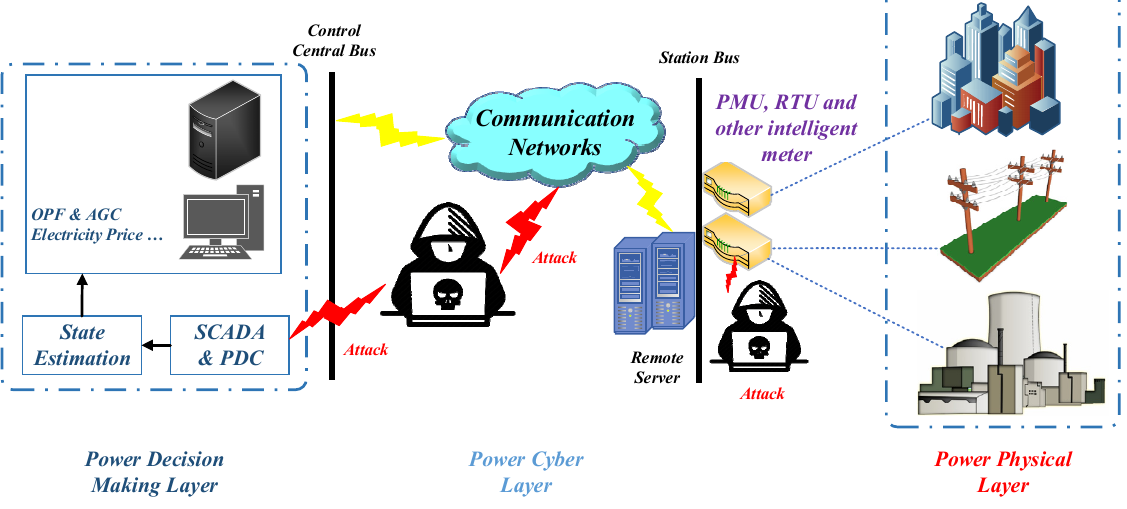
Figure 1. The power system framework configuration. Table 1. Explanation of scenarios.